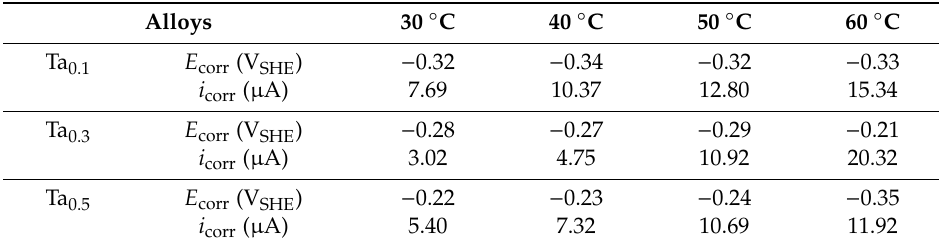
Table 4. Polarization data of as-cast CoCrFeNiTa x alloys in 1 M deaerated NaCl solution at di ff erent